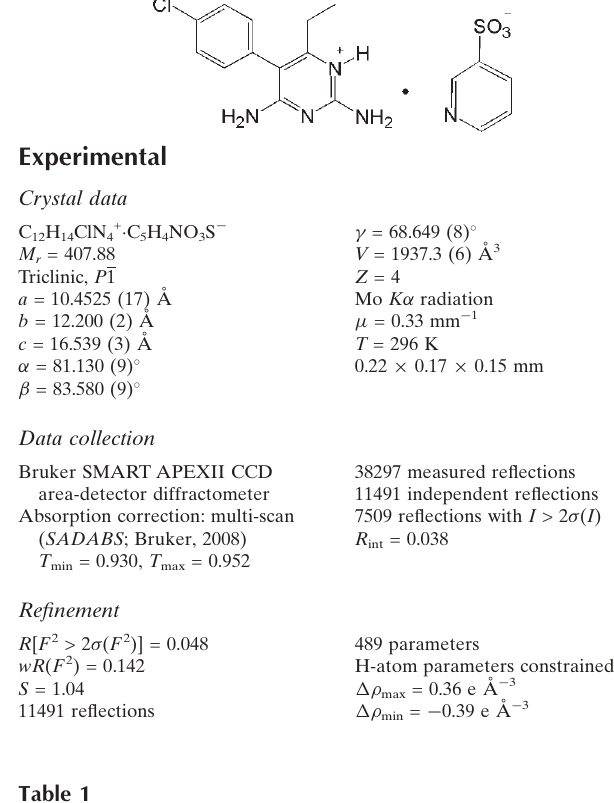
Hydrogen-bond geometry (A˚ , (cid:4)